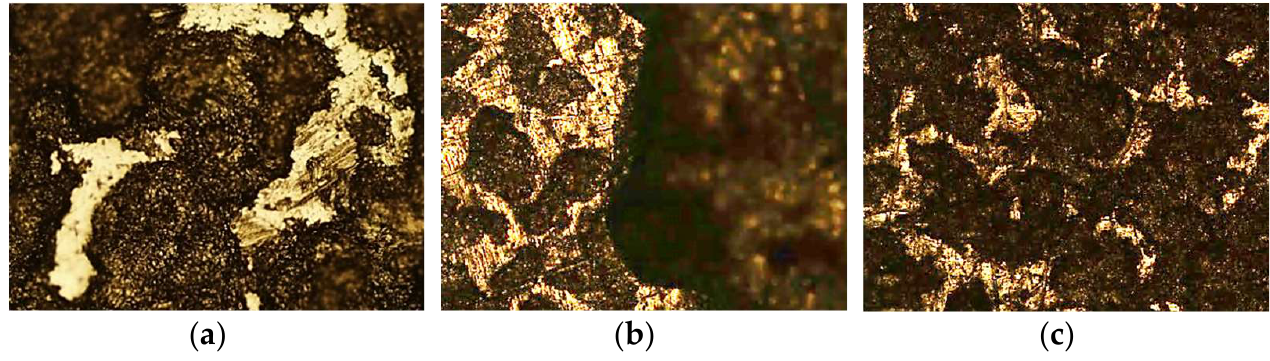
Figure 4. Optical microscope image of the AISI 321 sample at a magnification of 50×: ( a ) before immersion, ( b ) after three weeks, ( c ) after three months.